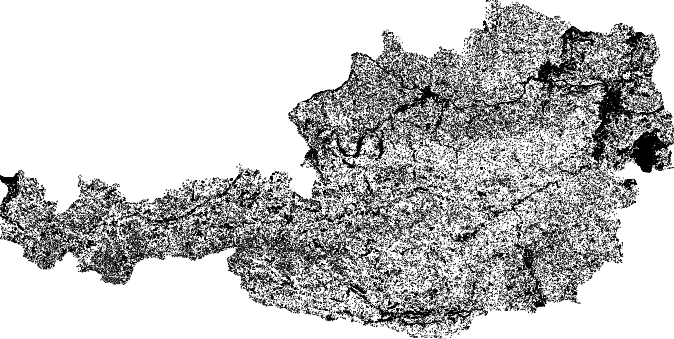
Figure 2. The 12,000 samples were randomly selected as ground truth for each LULC class to train and test the deep learning model (Perceiver network). These sample locations are illustrated in this map as black dots.